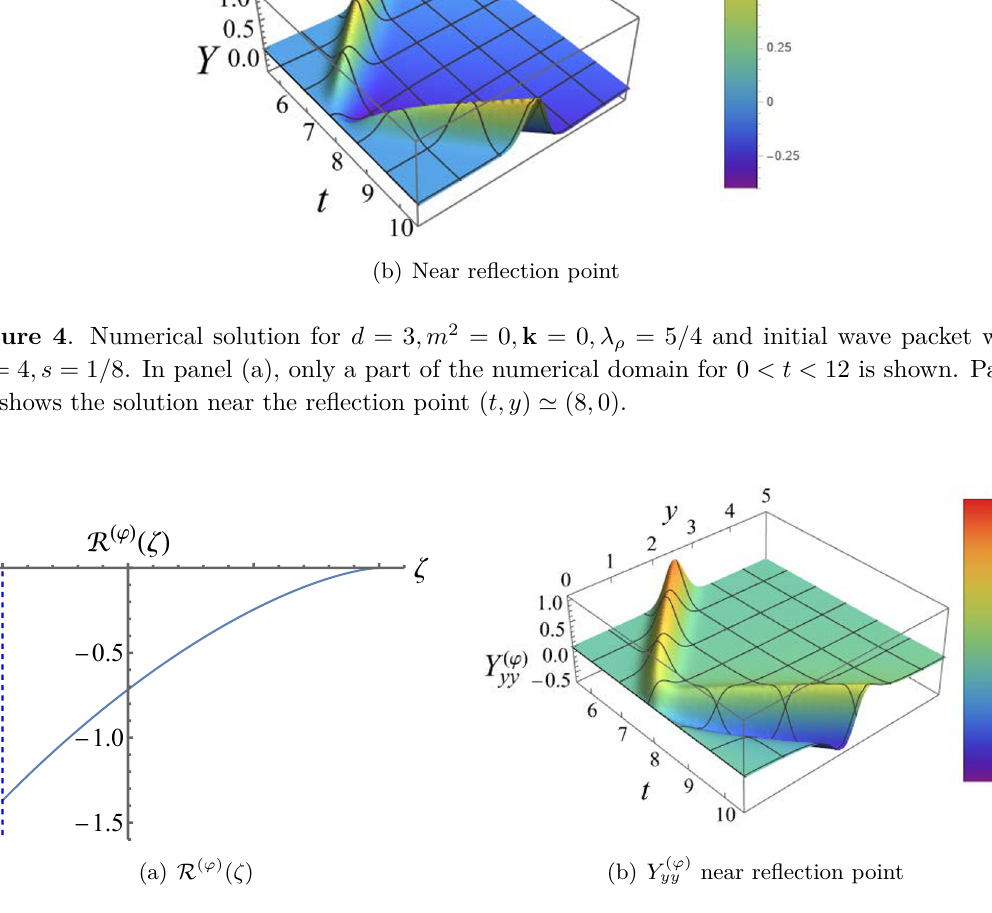
Figure 5 . The dynamics of the brane bending mode in d = 3 for the brane located at ζ = ζ ∗ = − 1 / 2 . Panel (a) shows R ( ϕ ) ( ζ ) analyzed in section 3.3. Panel (b) shows the time evolution of Y ( ϕ ) yy with k = 0 , for which m 2 = 0 , λ ρ = − 1 . The initial field configuration is the same as that for figure